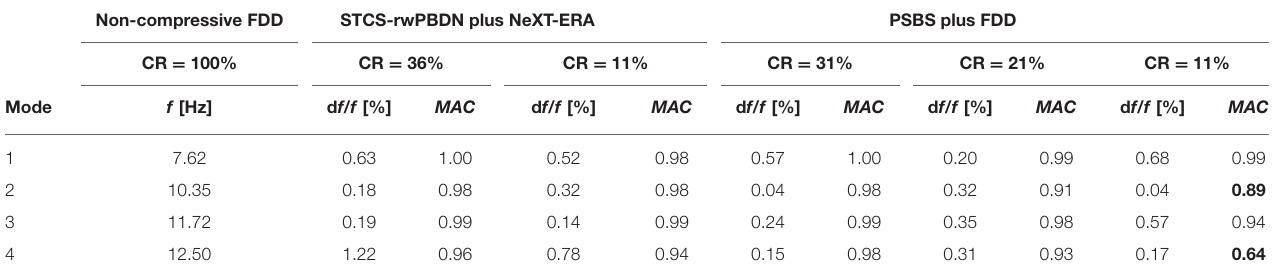
TABLE 3 | Quantitative assessment of the accuracy of natural frequencies and mode shapes for the bridge case-study obtained by the PSBS with FDD and by the STCS-rwPBDN with NeXT-ERA approaches for different CRs vis-à-vis standard non-compressive FDD approach. Non-compressive FDD STCS-rwPBDN plus NeXT-ERA PSBS plus